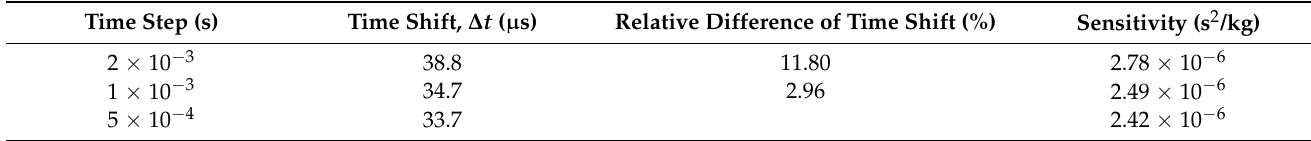
Table 3. Time discretization study for 8 m/s